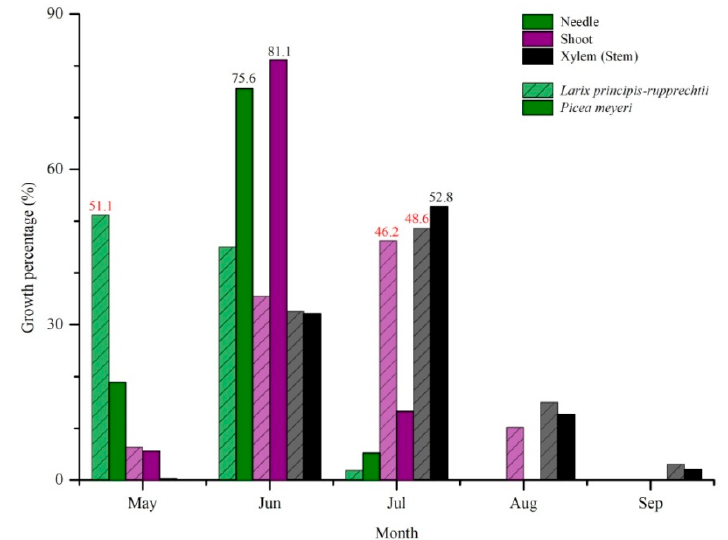
Figure 7. Percentages of primary and secondary growth at monthly intervals for larch and spruce.